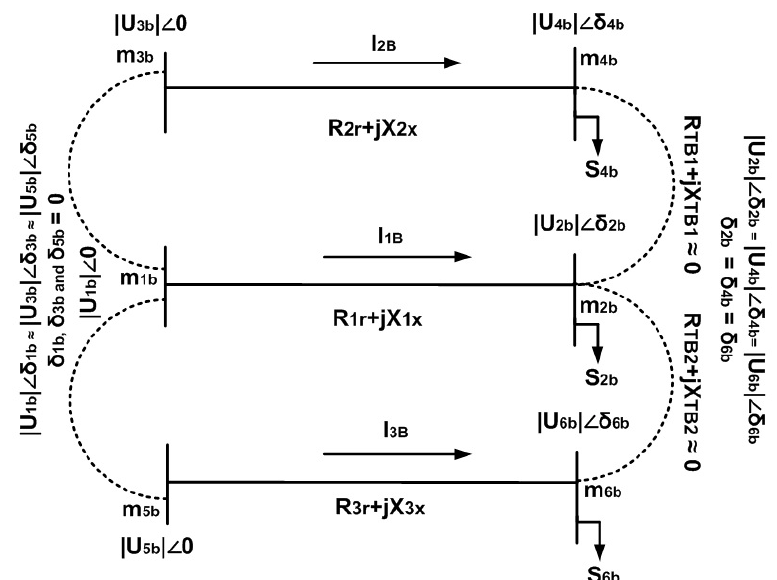
Figure 1. The electrical equivalent diagram of the model mesh distribution network.